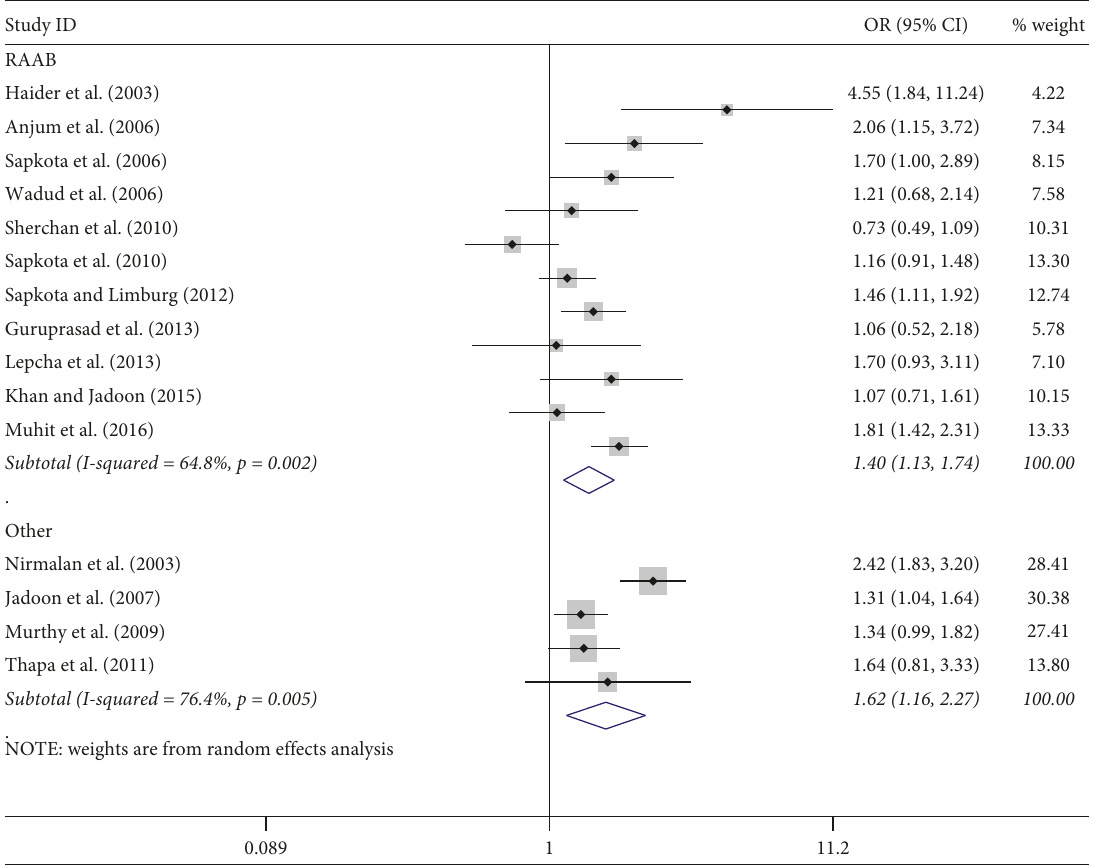
Figure 6: Subgroup analysis of CSC by design on a person basis at visual < 3/60 level. CSC � cataract surgical coverage; OR � odds ratio; CI � confidence